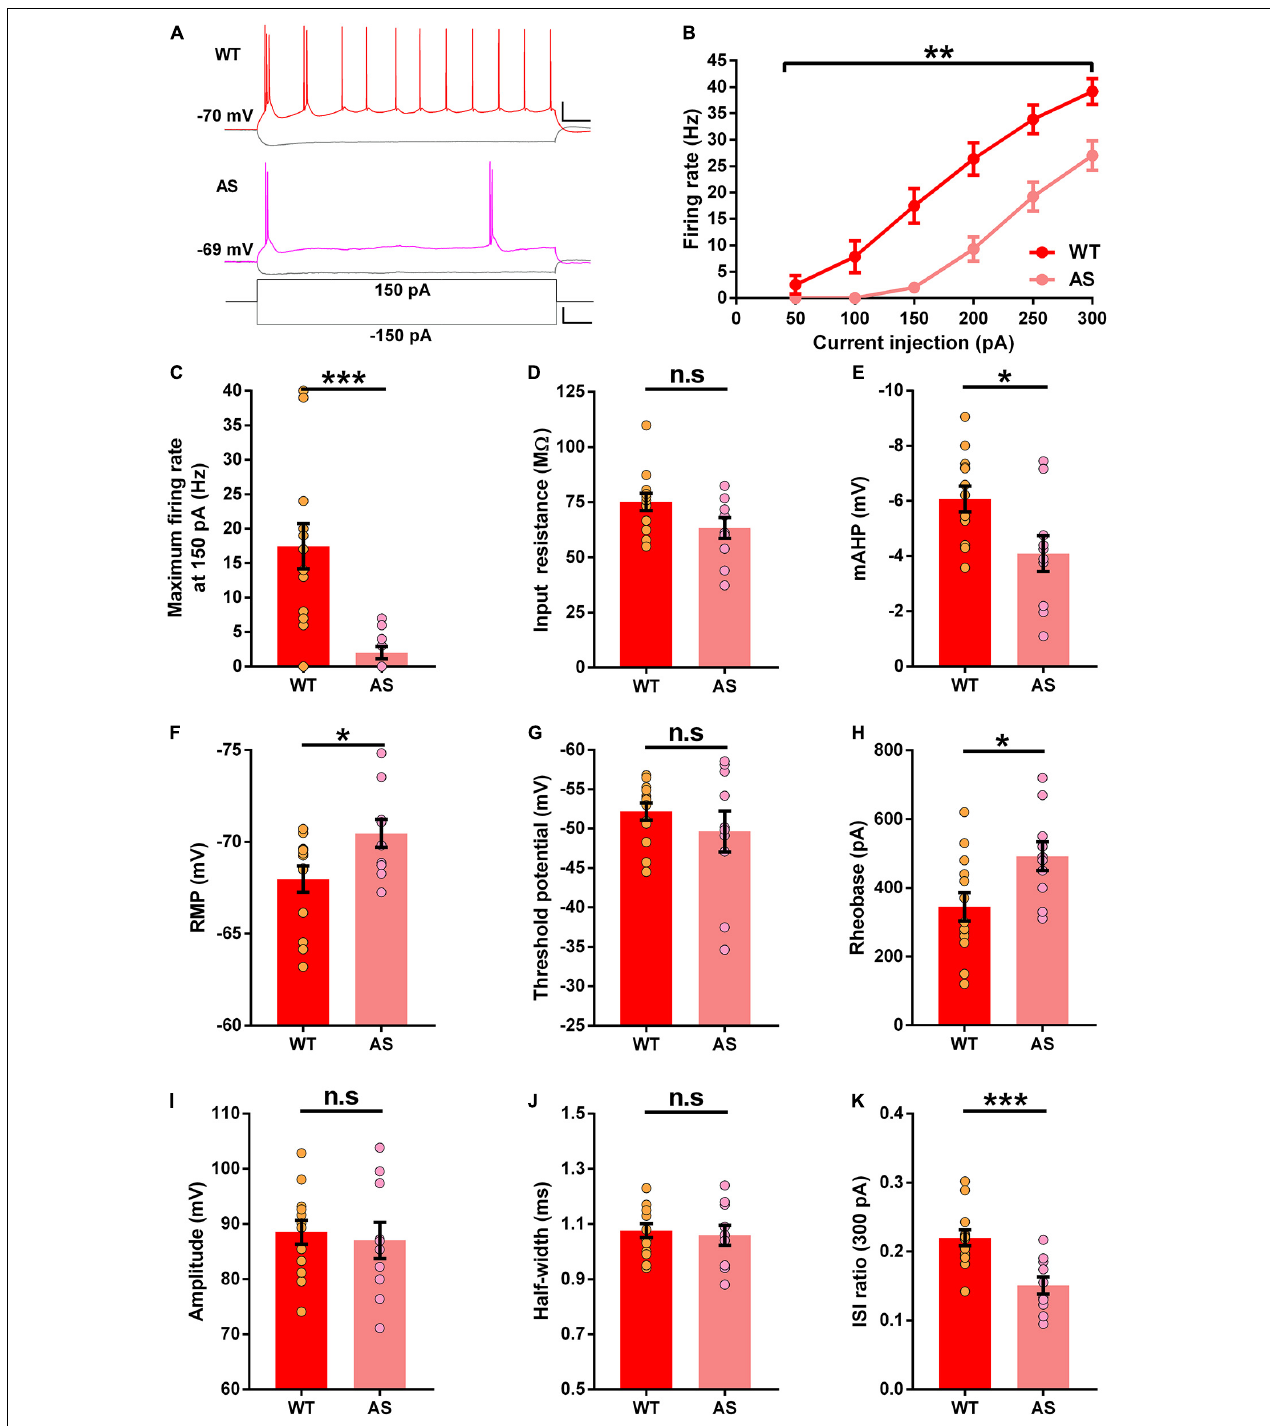
FIGURE 4 | Altered excitability in the subicular SB PNs of AS mice. (A) Example recordings illustrating the response following injection of a 150 pA depolarizing and a –150 pA hyperpolarizing current step in SB neurons of WT (Red), and AS (Fuchsia) mice. Scale: 20 mV, 100 ms. The bottom trace represents the step current used to elicit the above responses. Scale: 100 pA, 100 ms. (B) Firing response curves of all SB PNs summarized according to the genotype and current injection steps ranging from 50 to 300 pA. AS mice exhibit a reduction in firing frequency compared to their WT counterparts [ F ( 1 , 21 ) = 13.13, p = 0.001 for main effect of genotype; F ( 5 , 105 ) = 9.93, p < 0.0001 for interaction of genotype and current injection in two-way RM ANOVA; post hoc Bonferroni corrected comparison of current steps: t ( 126 ) = 4.32, p = 0.0002, t ( 126 ) = 4.77, p < 0.0001, t ( 126 ) = 4.10, p = 0.0005, and t ( 126 ) = 3.39, p = 0.005 for 150, 200, 250, and 300 pA respectively]. (C–K) Bar graphs with aligned dot plots representing the passive and active membrane properties of SB neurons. (C) The maximum firing rate at 150 pA